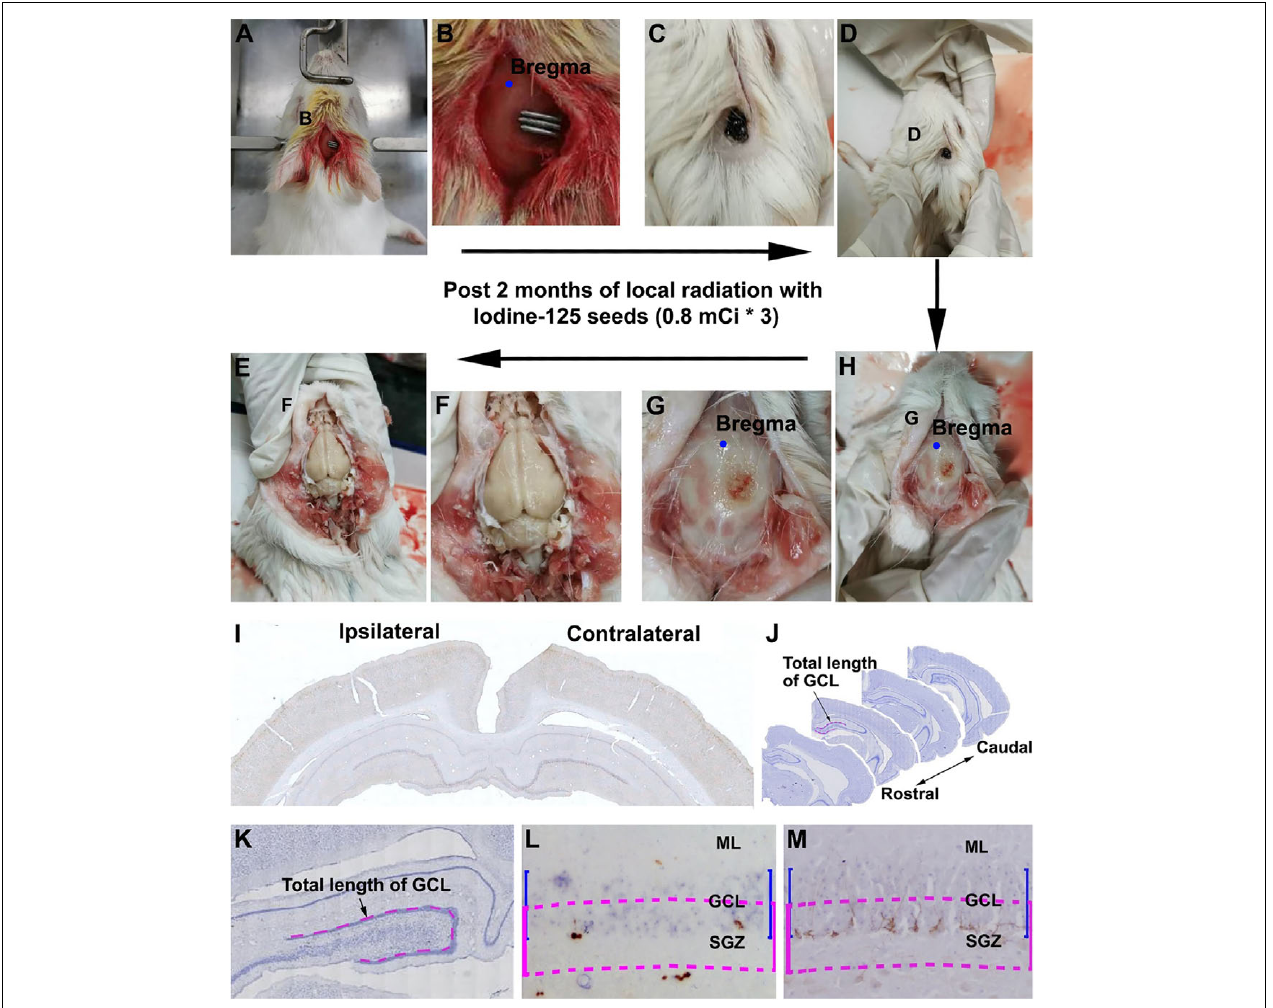
FIGURE 1 | Workflow of experimental procedure and quantification of immunolabeled cells. (A–E) Illustrate the experimental procedure from 125 I seed implantation to brain collection. (A,B) Show the initial placement of the 125 I seeds on the skull (5 mm posterior relative to the bregma and 1 mm lateral relative to the sagittal suture). (C,D) Show the presence of 125 I seeds in situ before brain perfusion. (G,H) Show the extent of damage to the skull after local radiation. (E,F) Show the appearance of the brain after the skull is open. (I,J) Show the rostrocaudal range of hippocampus subjected to quantification of immunolabeled positive cells. (K–M) Illustrate the method for counting immunolabeled Ki67 + (L) and DCX + (M) cells relative to the length of the granule cell layer (GCL). Cells within the band marked with blue line are counted, which is equal to the depth of the GCL but moved toward the hilus by half of the GCL thickness (purple